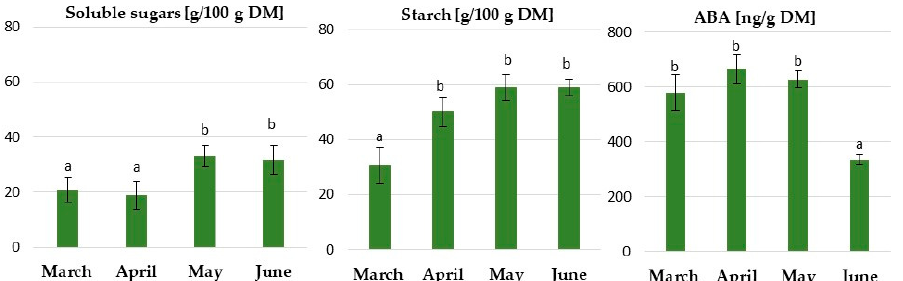
Figure 11. The effect of a long day and natural temperature in the greenhouse from early March to the end of June on the carbohydrate and ABA content of micropropagated rhubarb ‘Raspberry’ plantlets. Means indicated with the same letter within each carbohydrate and ABA do not differ significantly ( p = 0.05) according to Duncan’s test. Error bars represent standard deviation.